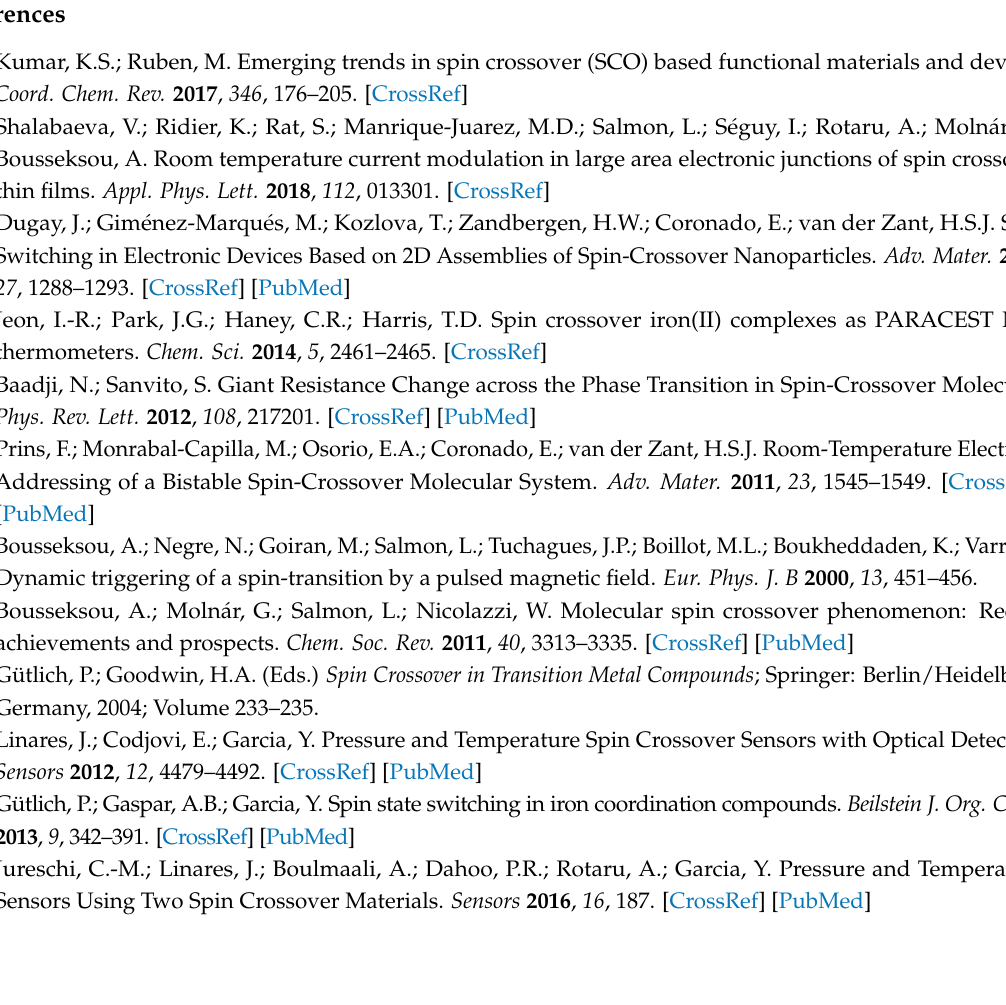
Figure S1: 1 H NMR spectrum of compound B (CDCl 3 , 300 MHz, 25 ◦ C), Figure S2: 13 C NMR spectrum of compound B (CDCl 3 , 75.4 MHz, 25 ◦ C), Figure S3: 1 H NMR spectrum of compound L6 (CDCl 3 , 300 MHz, 25 ◦ C), Figure S4: 13 C NMR spectrum of compound L6 (CDCl 3 , 75.4 MHz, 25 ◦ C), Figure S5: IR data ( ν /cm − 1 ) spectrum of complex [Fe(L6)](ClO 4 ) 2 ( 1 ), Figure S6: Structure of cationic complex of 1 showing the atom labelling scheme and the coordination environment of the Fe(II) ion, Figure S7: Thermogravimetric measurements of compound 1 at a heating rate of 10 K/min in the temperature rage 300–980 K. Inset shows a zoom of the decomposition peak at ca . 472 K, Figure S8: DSC scans for two different samples of compound 1 for different heating and cooling scans at a scan rate of 10 K/min, Figure S9: Observed and calculated X-ray powder diffraction patterns for complex 1 , Table S1: Selected bond distances (Å) for complex 1 (see Figure S6 for the atom labelling scheme), Table S2: Selected bond angles ( ◦ ) for complex 1 (see Figure S6 for the atom labelling